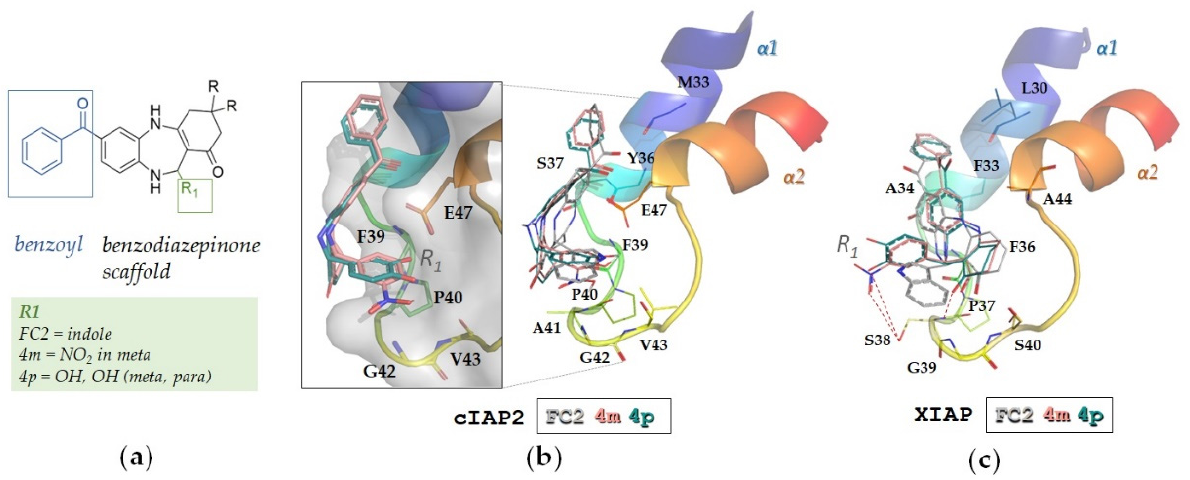
Figure 2. The FC2 and FC2 derivative portions, the benzoyl, the benzodiazepinone central scaffold and the R 1 groups ( a ) map a set of conserved residues in the target hotspot. Compounds 4m and 4p poses (pink and teal, respectively) in the BIR1 domains of cIAP2 ( b ) and XIAP ( c ) maintain the interaction network of FC2 (grey lines) with the residues (highlighted in lines) of the structural hotspot α 1-turn- α 2 (in rainbow cartoons). In the zoomed view (left side of panel b ), R 1 substitutions with electron withdrawing groups ( 4m , 4p ) engage novel interactions with key residues of the turn and with E47 ( 4p ) in cIAP2. In XIAP, both 4m and 4p gain novel interactions between R 1 and S38 side chain and between the carboxy moiety of the scaffold and S38 backbone (red dashed lines). The structures were drawn with Pymol